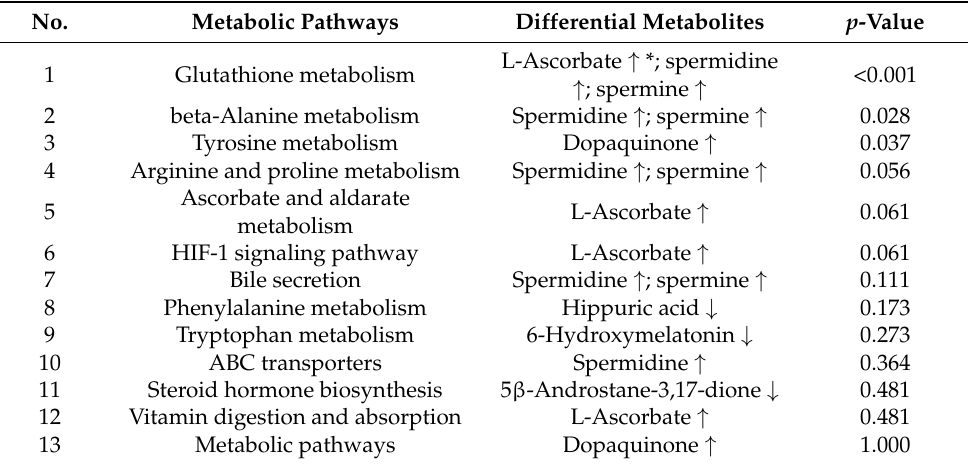
Table 6. A comparison of the concentrations of metabolites in pancreas tissue from yak calves fed alfalfa hay or oat hay.